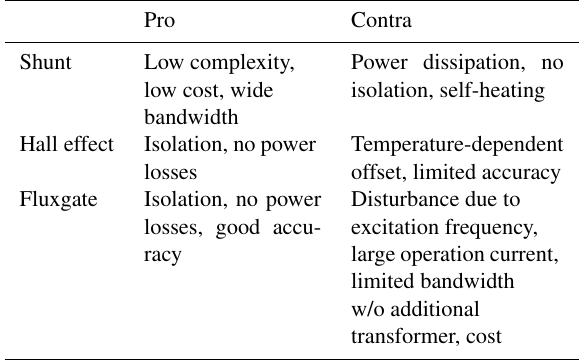
Table 1. Comparison of current measurement techniques suitable from DC up to several tens of kilohertz. Pro Contra Shunt Low